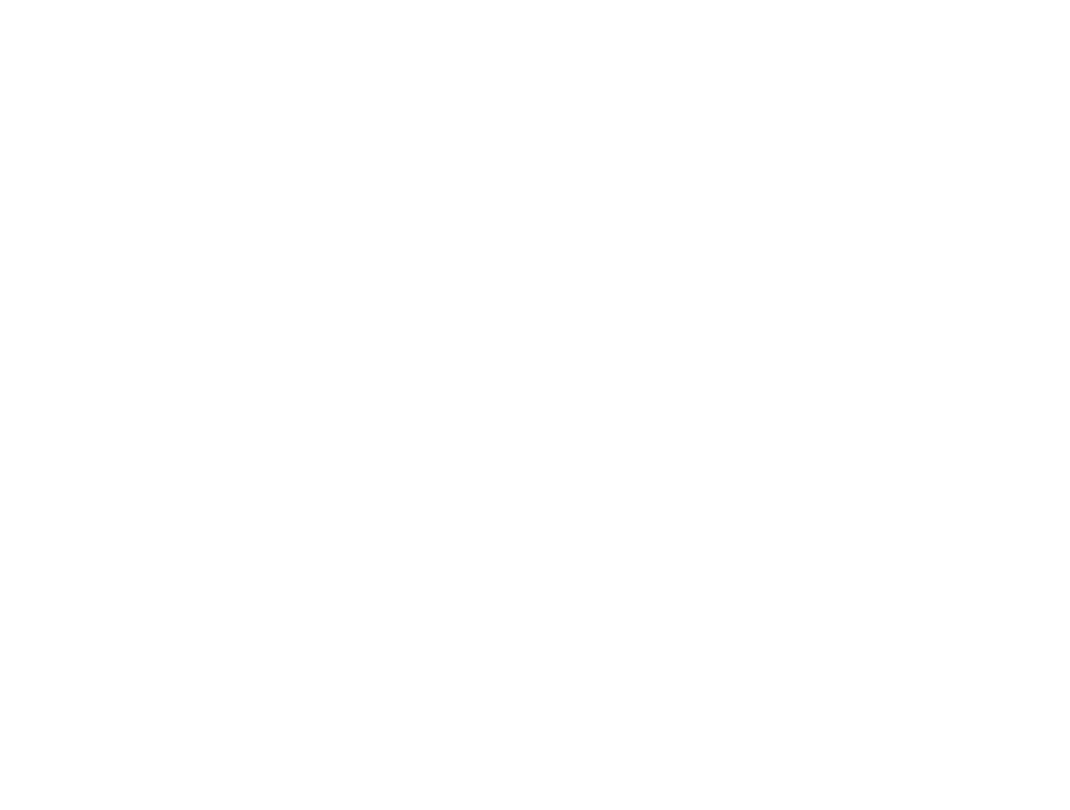
interaction; paths b i are the direct effects of the mediators on the dependent variable anger. Path c is the total effect of the culture × scenario interaction on anger; path c (cid:48) is the direct effect remaining once the indirect effects via the potential mediator variables are taken into account. A significant c path in conjunction with a non-significant c (cid:48) path indicates complete mediation, but the analyses we employed also permit direct significance testing of the a i b i